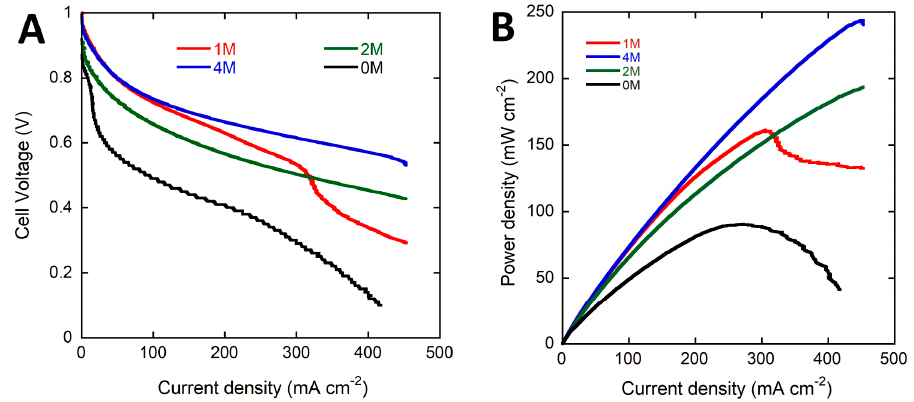
Figure 2. Potential ( A ) and power density ( B ) (vs. current density) curves for the DFFC containing the Pd/C-CeO 2 anode, FeCo/C cathode, A201 AEM and fueled with 4 M HCOOK and various concentrations of KOH electrolyte (0, 1, 2 and 4 M) (T cell 60 ◦ C and V scan 10 mV · s − 1 The performance of the DFFC is highly dependent upon the KOH electrolyte concentration. As can be seen in Table 1 the peak power density decreases from 243 to 206 and to 159 (mW·cm − 2 ) as the KOH concentration drops from 4 to 2 and 1 M. Mass transport limited cell performance is observed in the 4/1 fuel solution at higher current densities due to excessive consumption of KOH near the electrode surface. The voltage curve obtained with no added KOH shows a significant drop in the cell potential at low current densities caused by poor FOR activity of the anode catalyst at the mildly alkaline conditions of the 4 M HCOOK solution. A peak power density of 89 mW·cm − 2 is obtained with no KOH, 40% of that obtained with an equivalent molar amount of KOH in the electrolyte (4 M).